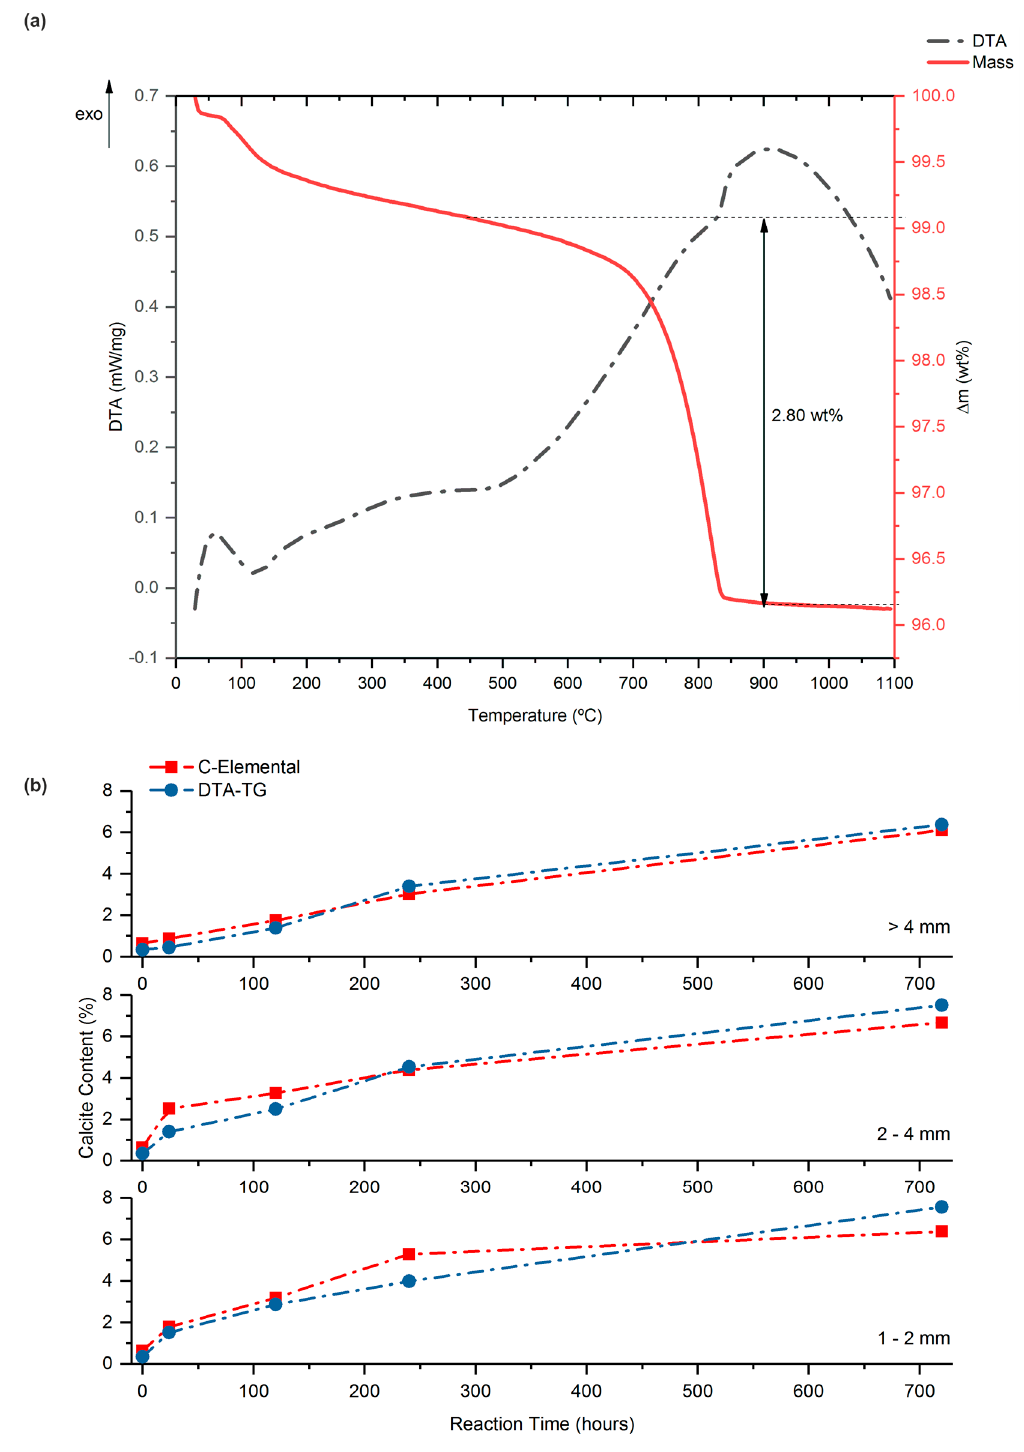
Figure 6. ( a ) MPC2 thermogravimetry (solid line) and di ff erential thermal analyses (dashed line); > 4 mm and 720 h reaction time. ( b ) Calculated calcite content by DTA-TG (circle) and by C element (square) as function of reaction time and particle size fraction (modified from [5]).